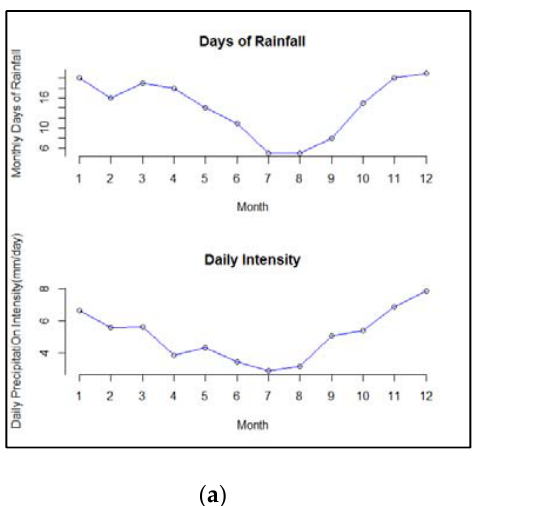
Figure 8. Average monthly volume (mm) over the period of record for all stations. Box shows 50% of the data, with median represented as a black bar. The whisker extends to two standard deviations of the data, and circles represent outliers.